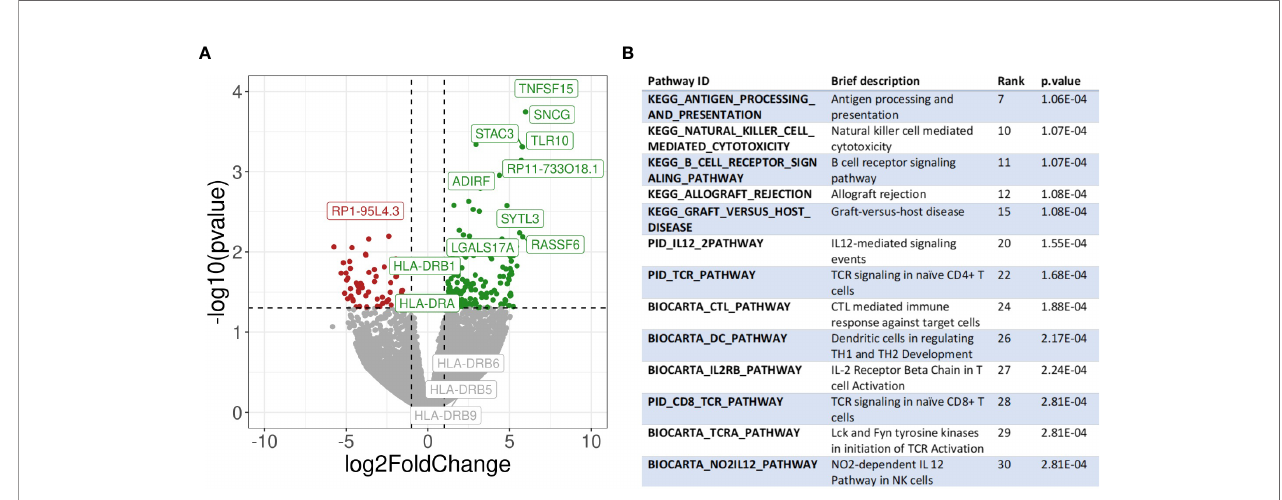
FIGURE 6 | Transcriptomic analysis. (A) Volcano plot showing differential gene expression between HLA-DR+ and HLA-DR- tumour areas. The x-axis represents the log2 of the fold change while the y-axis represents the -log10 of the p-value derived from a t-test. P-values here are not corrected for multiple comparisons given the low number of samples included in the analysis. Dashed lines represent the typical thresholds used in differential gene expression to de fi ne signi fi cance (1 and -1 for the log2FoldChange and -log10(0.05) for the p-value). Genes in the top-right corner (green) are overexpressed in HLA-DR+ areas compared to HLA-DR- areas while genes in the top-left corner (red) are overexpressed in HLA-DR- areas. The gene names for the top 10 most signi fi cant genes are also included in their respective position. Differential gene expression of different HLA-DR genes are also included among the gene names. (B) Pathway analysis of HLA-DR+ areas compared to HLA-DR- areas. Interesting pathways from the top 30 up-regulated pathways are